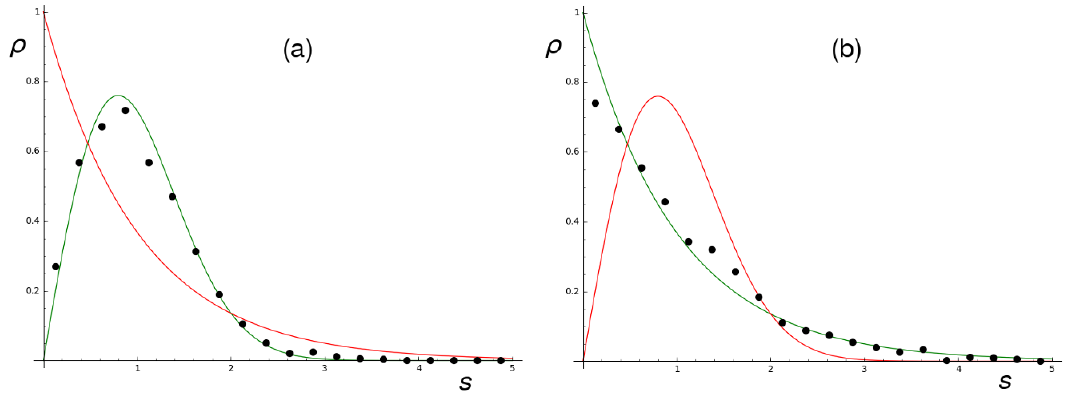
Figure 1 . Eigenvalue spacing distibutions obtained for the quantized SNH resonant system in three (a) and four (b) spatial dimension for a particular eigenvalue block with N = 27 and E 0 = 27. By inspection, (a) follows the ‘Wigner surmise’ distribution associated with chaotic systems, while (b) follows the Poisson distribution that alludes to its special structure (‘partial integrability’) discussed in section